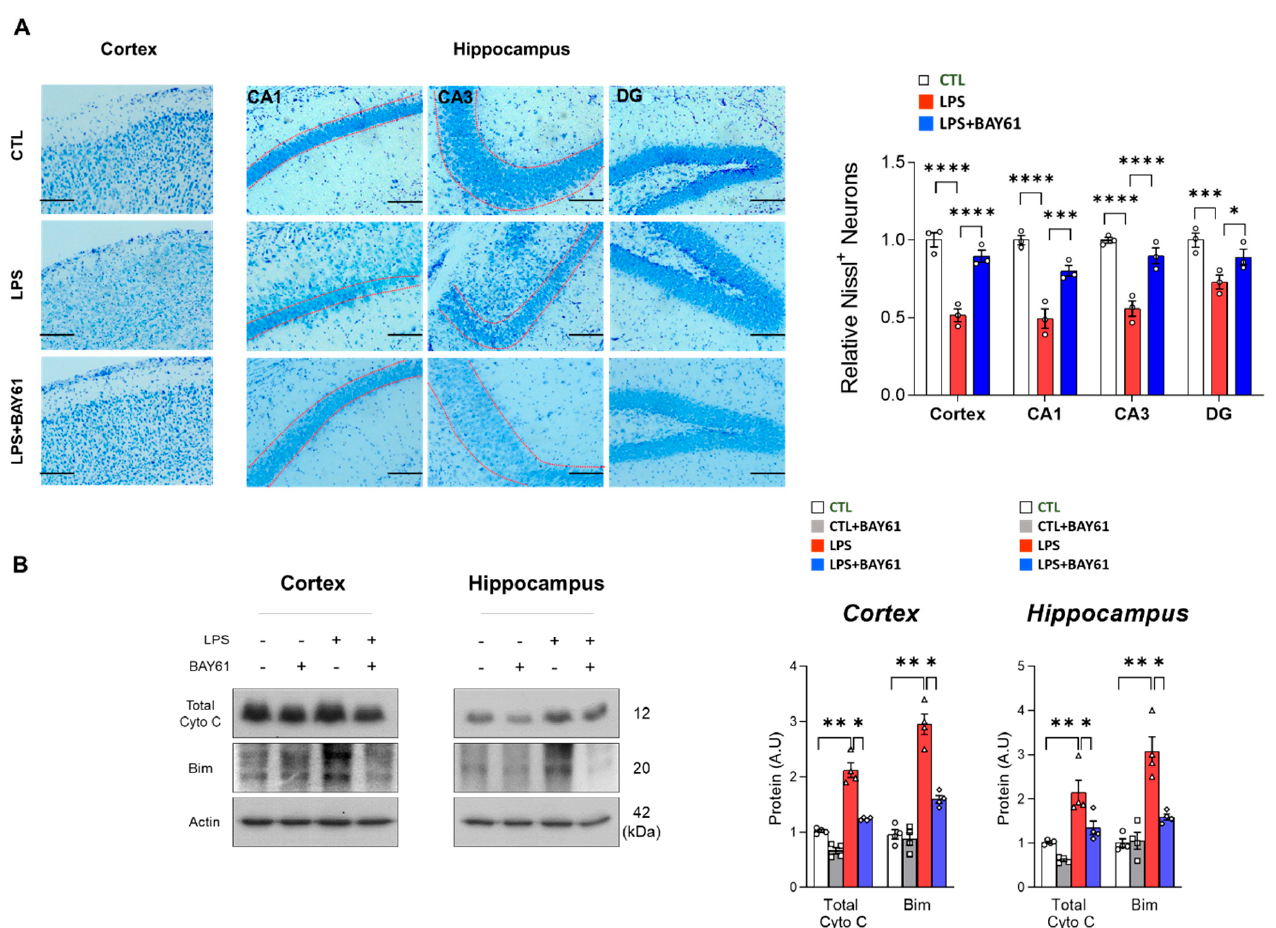
Figure 5. BAY61-3606 alleviates LPS-induced neuronal cell death. ( A ) Representative Nissl images of cortex and specific hippocampal regions (Cornu ammonis (CA)1, CA3, and dentate gyrus (DG)) after intraperitoneal injection of LPS (0.25 mg/kg per animal) and BAY61-3606 (10 mg/kg) for 9 days ( n = 3). Scale bars, 50 µ m. ( B ) Immunoblot of cytochrome C and Bim in the cortex and hippocampus. Bar graph color, white: control, grey: control with BAY61-3606, red: LPS, blue: LPS with BAY61- 3606. Values indicate the mean ± SEM. The significant differences have been given in the graphs as follows: * p < 0.05, ** p < 0.005, *** p < 0.0001, **** p < 0.00001 compared with a group of interests and determined by one-way ANOVA followed by Tukey’s multiple comparison test. Abbreviations: Syk, tyrosine-protein kinase; LPS, lipopolysaccharide; Bim, BCL-2-like protein 11.